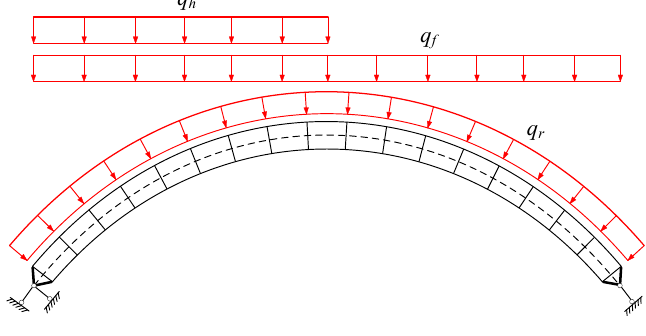
Figure 4. Different loading cases considered in this